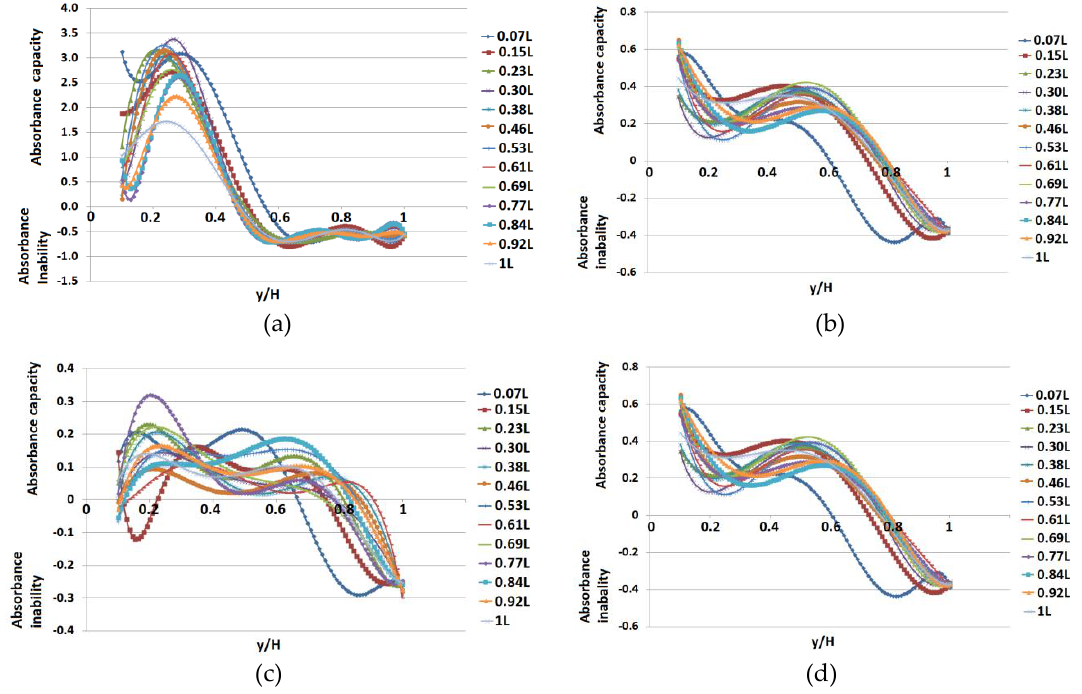
Figure 4. Absorbance ability for the case of θ = 45° for different lengths and heights inside the micromixer device for a) Vp/Vc = 0.5, b) Vp/Vc = 5, c) Vp/Vc = 10, d) Vp/Vc = 20.